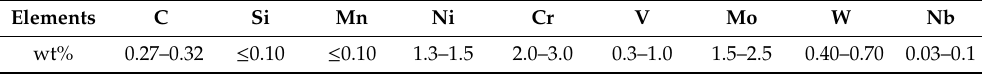
Table 5. Preliminarily formulated alloy 25Cr3Mo2NiWVNb composition range.